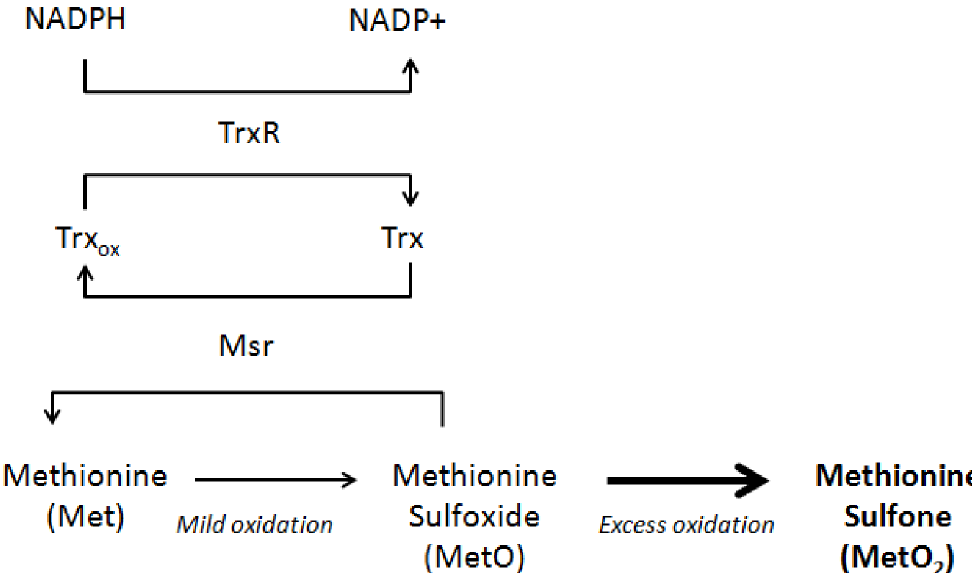
Fig 1. The Methionine-Centered Redox Cycle. The formation of methionine sulfoxide (MetO) can result from the oxidation of free methionine, or a methionyl residue of a protein. Additional oxidation will generate methionine sulfone (MetO 2 ), a product that is almost irreversible in biological systems, and can cause protein denaturation. MetO can be reduced by methionine sulfoxide reductases (MsrA or MsrB isoform), through thioredoxin (Trx). Thioredoxin reductase (TrxR) regenerates the oxidized Trx (Trx ox ) via critical components of the cellular redox system, NADP/NADP(H)